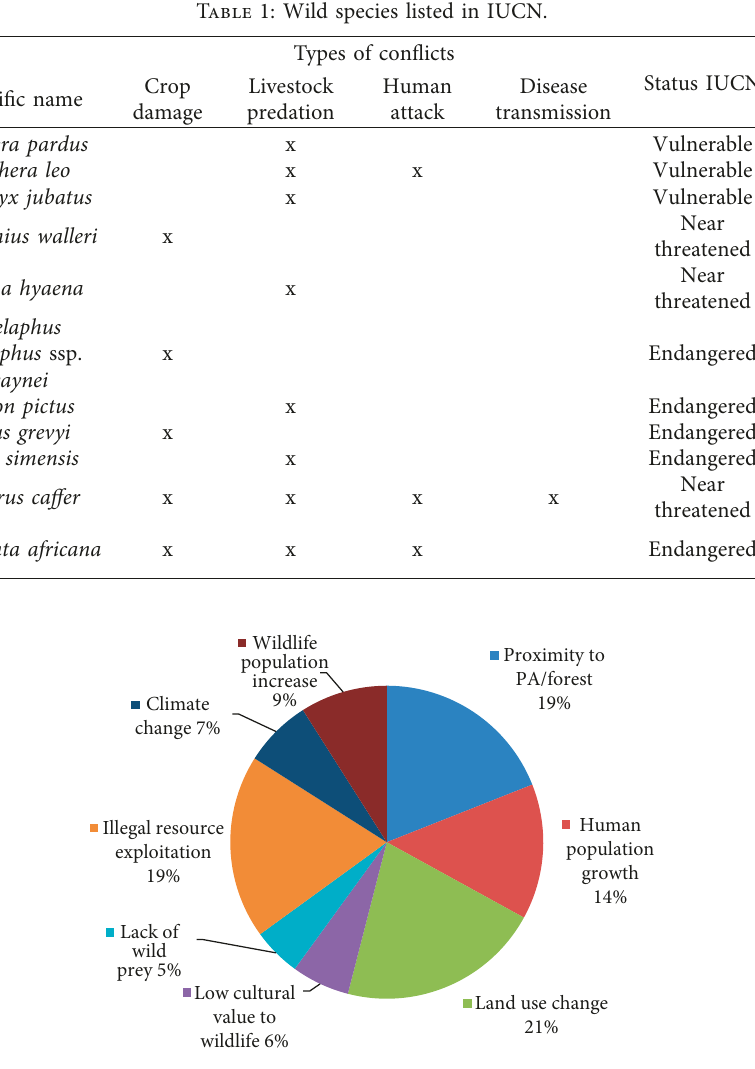
Figure 5: Drivers of HWC-related change considered by articles expressed in percentages.